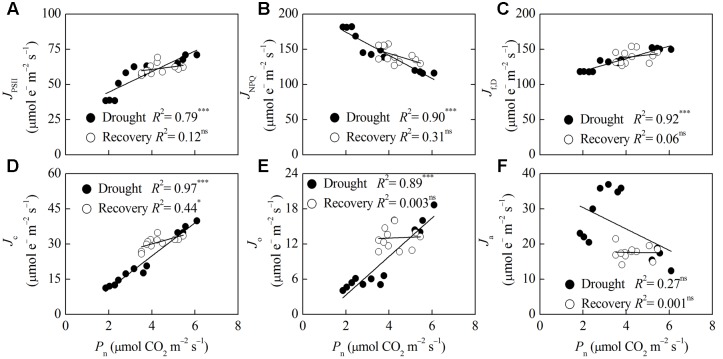
Relationship between net CO2 assimilation (Pn) and different energy partitioning processes in F. rufa leaves under drought and rewatering. The regression lines are: (A)
y = 7.31x + 29.90, (B)
y = –16.51x + 207.48, (C)
y = 8.87x + 101.29, (D)
y = 7.06x – 3.30, (E)
y = 3.29x – 3.29, (F)
y = –3.04x + 36.49 (for drought); and (A)
y = 1.92x + 52.98, (B)
y = –9.36x + 181.61, (C)
y = 3.47x + 124.58, (D)
y = 2.57x + 19.78, (E)
y = 0.15x + 12.41, (F)
y = –0.07x + 17.90 (for rewatering). Data are measured values of four replicates per treatment at the same stage (error bars are omitted for clarity). The solid lines represent the best-fit linear regressions: ∗P < 0.05; ∗∗∗P < 0.001; ns, not significant.